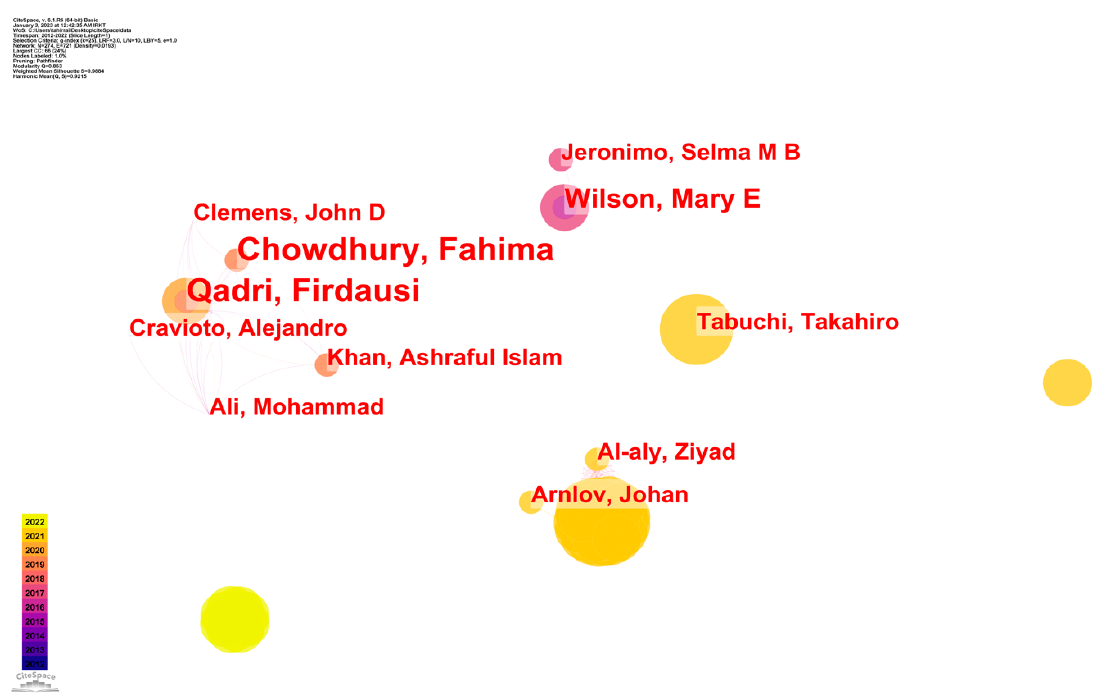
Figure 4. CS Map of Author co-authorship analysis of studies of epidemic control based on big data research.